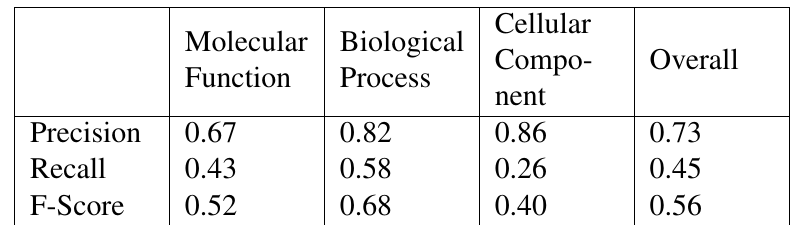
Figure 7: Evaluating our PFAM based GO mappings to an Arabidopsis reference set from publicly available GOA files.